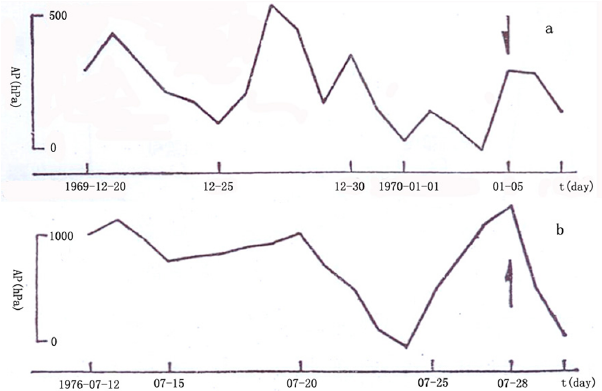
Fig. 11. Air pressure variation related to strong earthquakes (Ma et al., 1982). (a) Tonghai earthquake M = 7.7 of 5 January 1970, (b) Tangshan earthquake M = 7.8 of 28 July 1978 (arrow points to the day in which earthquake